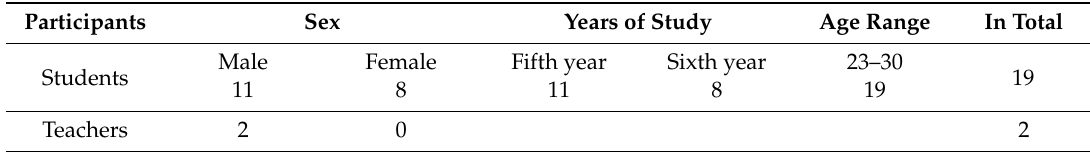
Table 1. The basic sociodemographic data of the